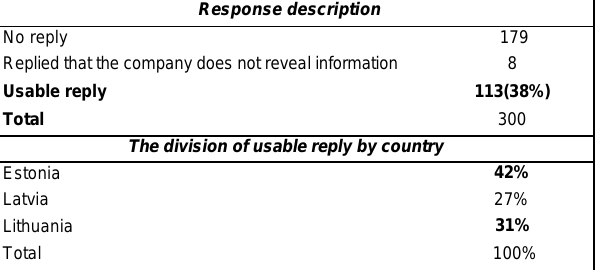
Table 5. The Response to the